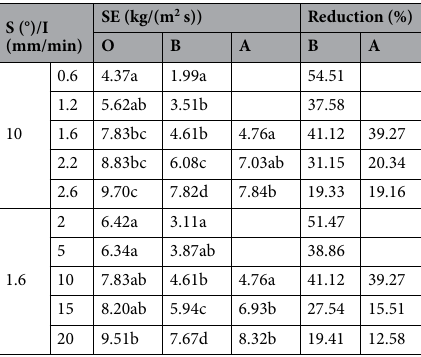
Table 4. Sheet erosion rates and their regulating effects of two planting methods. a, b, c, d are the difference comparison of LSD , and the significance level is 0.05. O is bare slope, B is Prunella vulgaris combined with earthworm planting slope,A is Single planting prunella vulgaris slope.